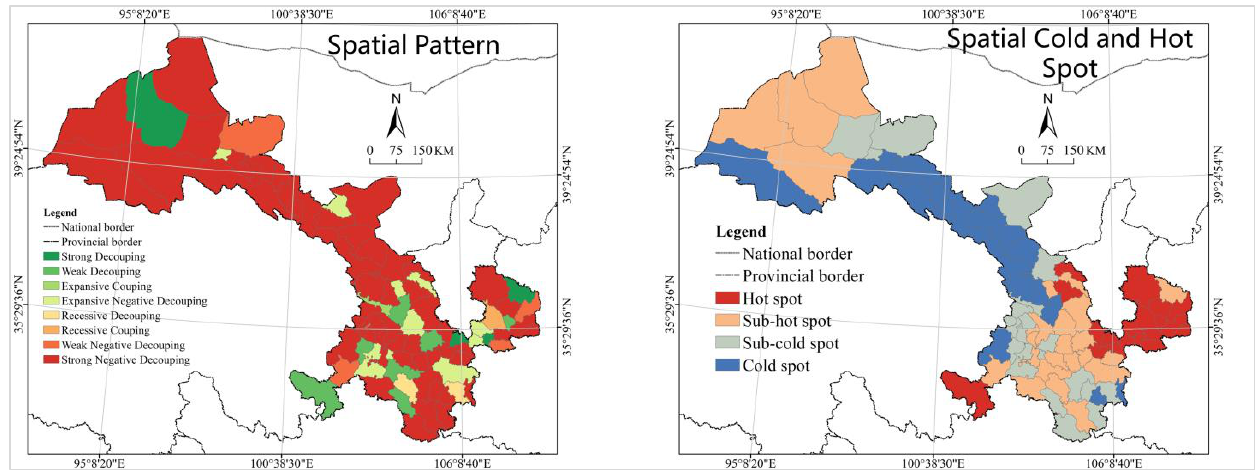
Figure 15. Spatial analysis on the decoupling relationship between urban construction land and final decoupling result in Gansu .